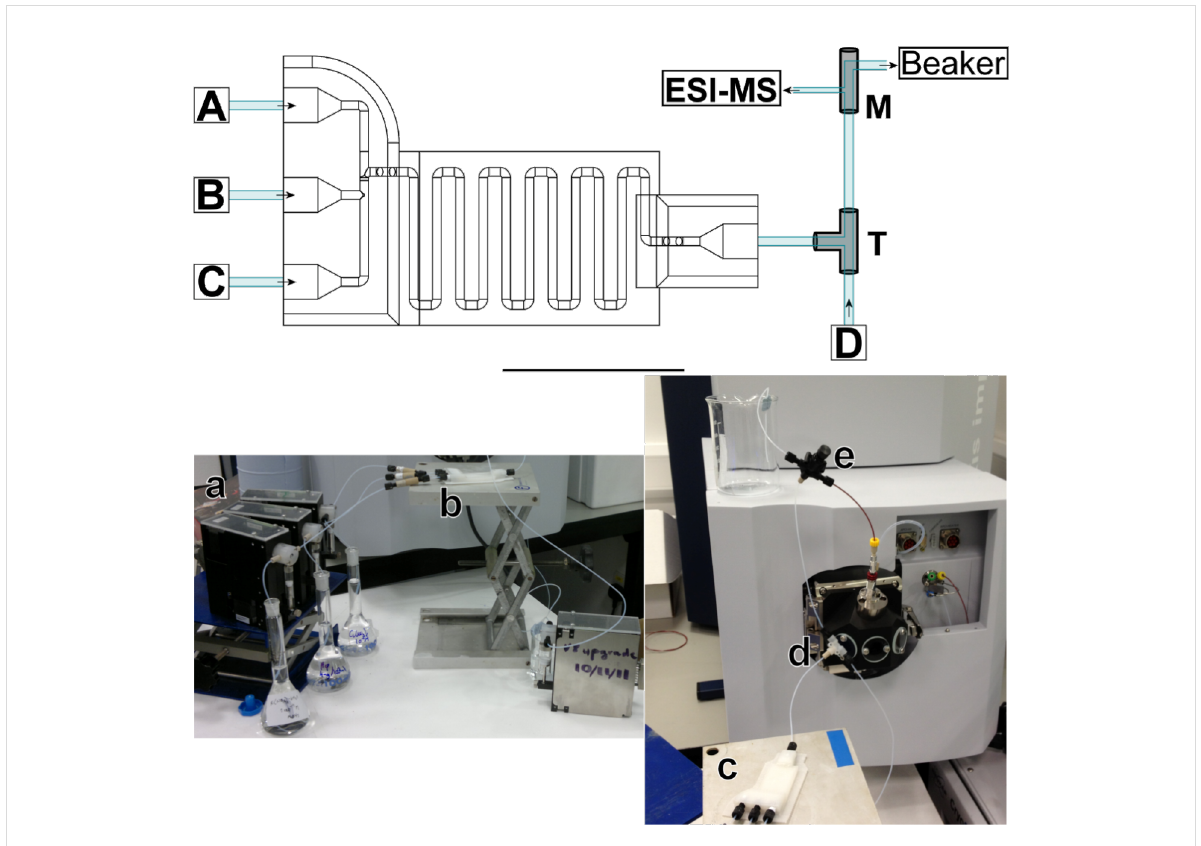
Figure 2: Top: A schematic overview of the device setup. The three inlets were each connected to a syringe pump, which were connected to stock solutions of the required starting materials or MeOH. The outlet is directly connected to a T-piece, where it mixes with a stream of MeOH for dilution. This is followed by the splitting step, where a PEEK microsplitter valve is used to split the stream so that only a suitable flow-rate reaches the ESI-MS. The parallel stream allows for collection of the reaction product. Bottom: Photograph of the device setup and connection to the mass spectrometer (where a = Tricontinent C-3000 syringe pumps; b = screw fittings; c = 3D printed device; d = T-piece; e = PEEK microsplitter valve).